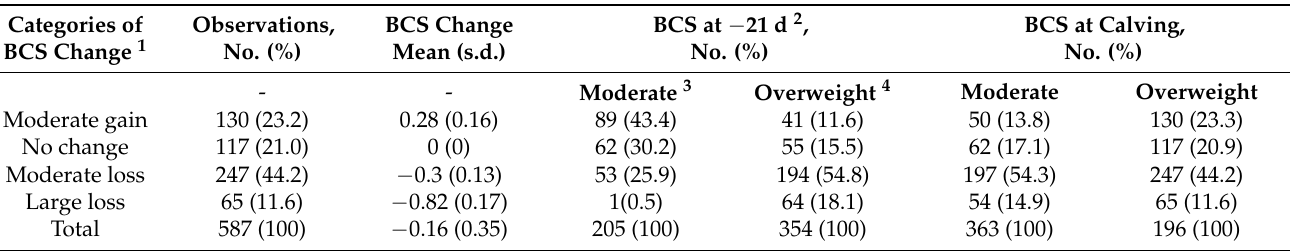
Table 1. Descriptive statistics for body condition score at two different points of the late dry period ( − 21 d and at calving), presented for the four categories of change in BCS and the overall average.